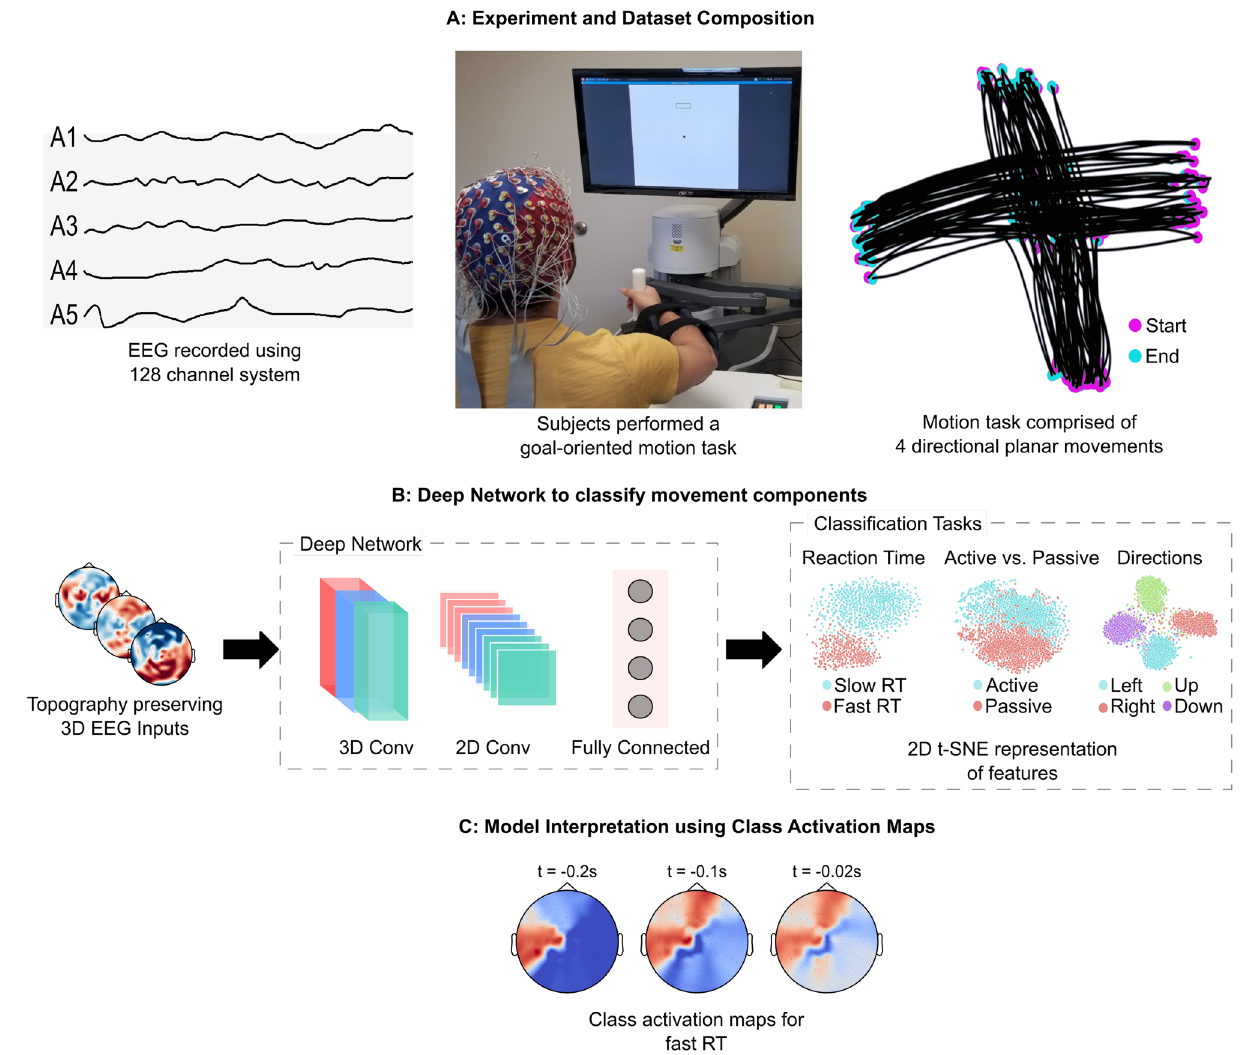
Figure 1. Experimental setup and study workflow. ( A ) 12 subjects performed a goal-oriented motion task (center) while high density EEG data (left) were simultaneously acquired with movement kinematics (right). ( B ) The proposed 3D-CNN received topography-preserving EEG inputs, and classified complex components of hand movements. ( C ) Gradient-weighted Class Activation Maps were developed to identify the relevant location and timing of activated brain areas per classification